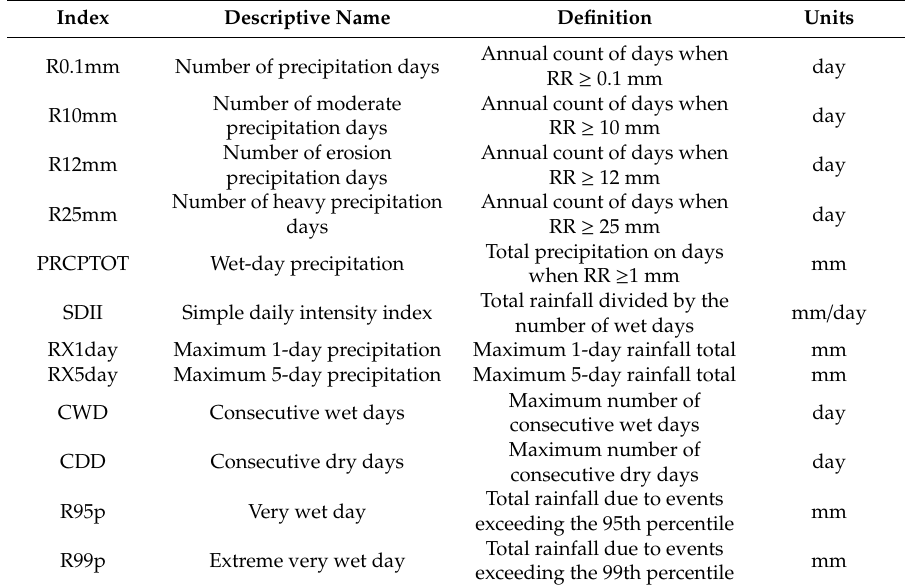
Table 2. Detailed information regarding the twelve extreme precipitation